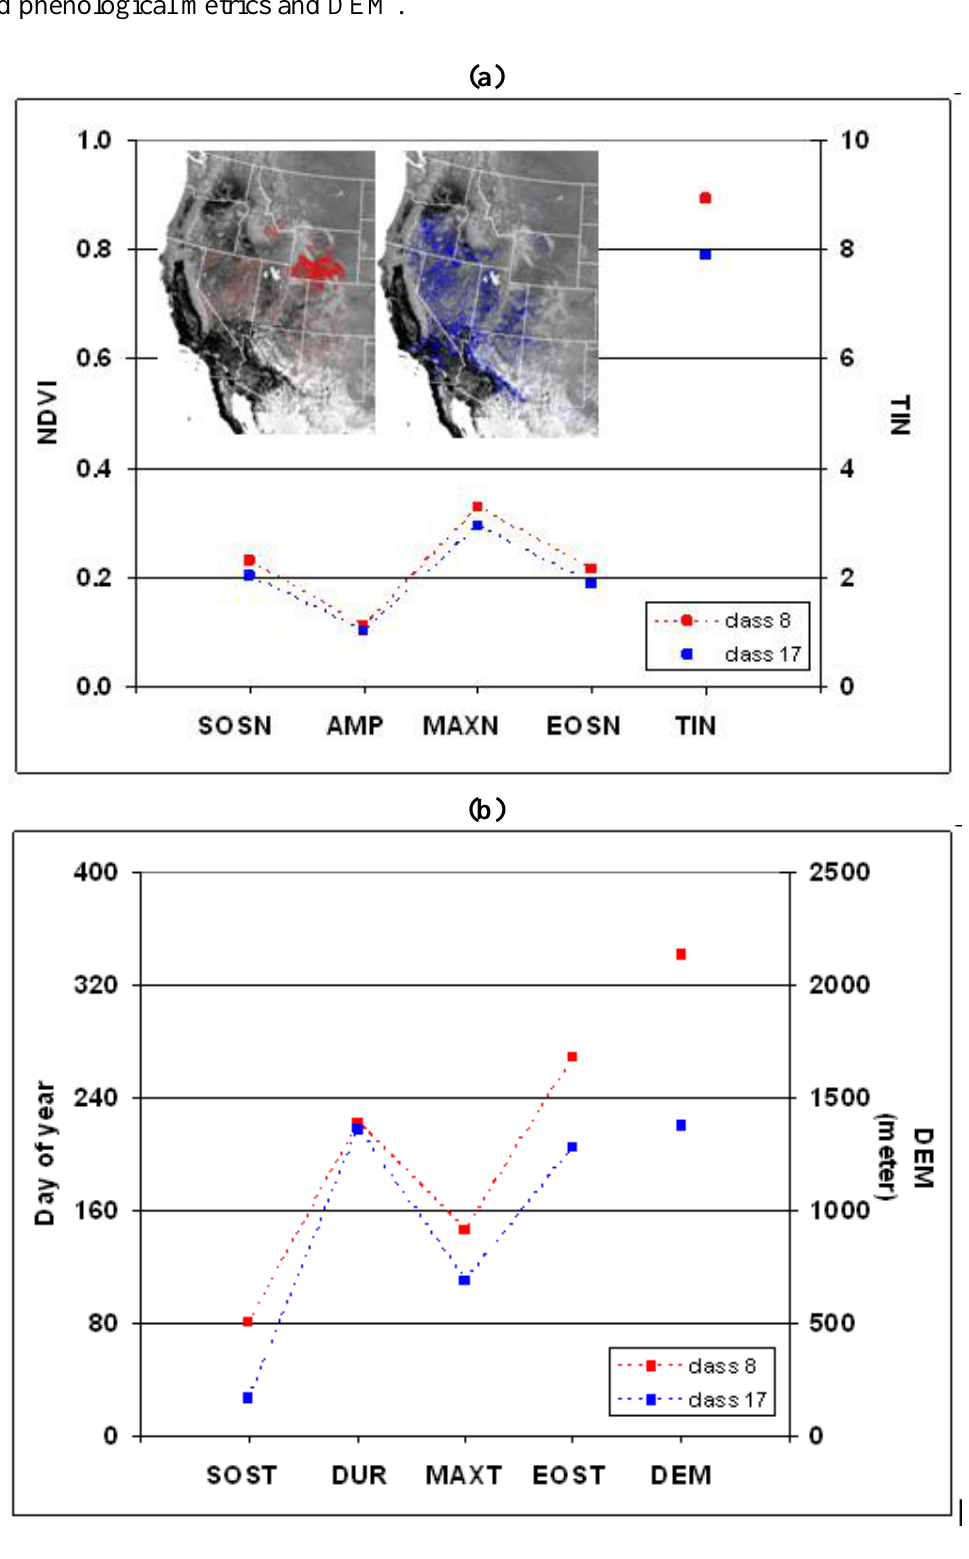
Figure 4. Mean values of the nine phenological metrics and the associated elevation data for pheno-classes 8 and 17. The geographic distributions of locations for these two pheno- classes are also shown in the figure. (a) NDVI-based phenological metrics; (b) timing- based phenological metrics and